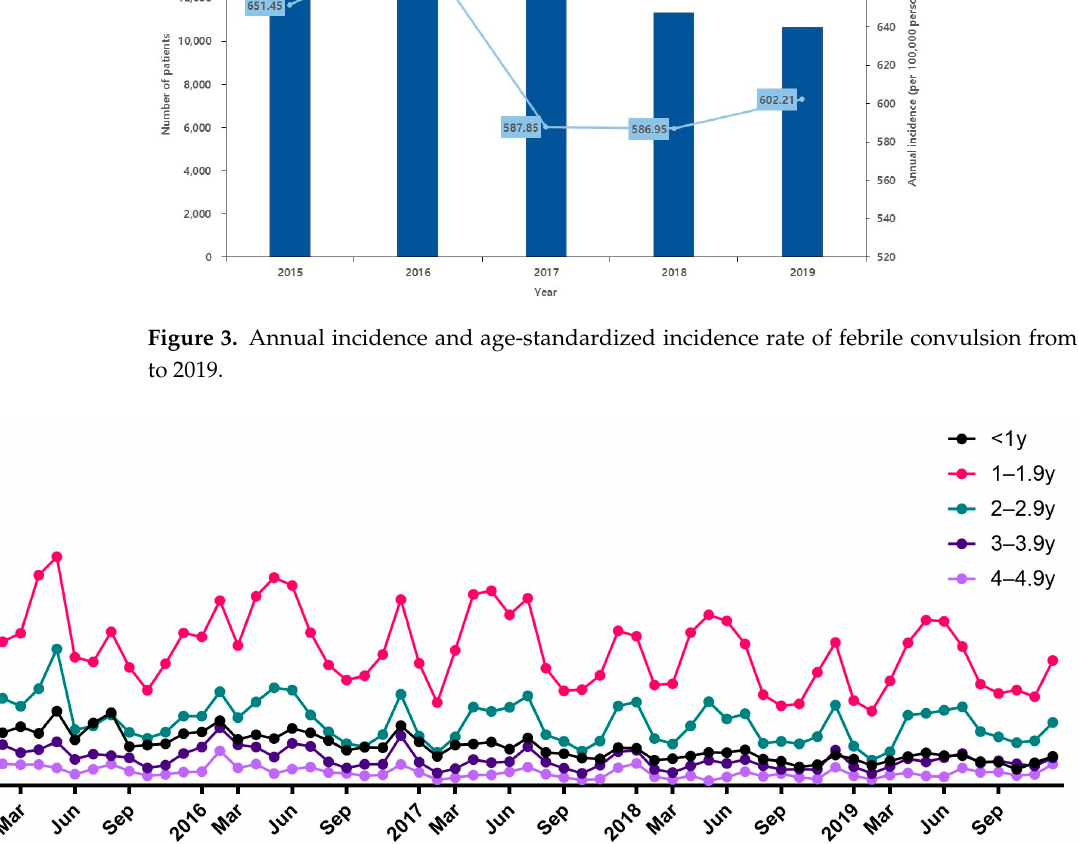
Figure 4. Monthly incidence trend of febrile convulsion according to age group from 2015 to 2019.